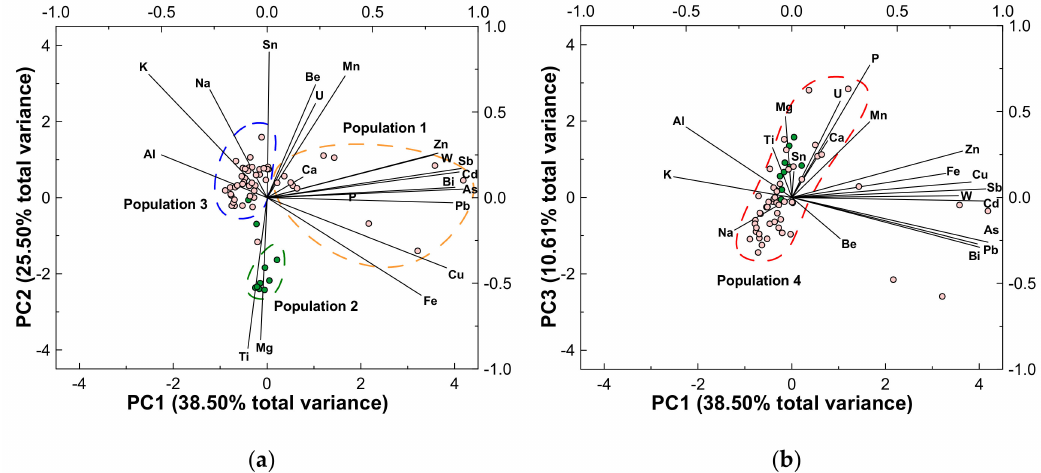
Figure 5. ( a ) Biplot of principal component 1 (PC1) versus principal component 2 (PC2) and ( b ) bivariate diagram with principal component 3 (PC3) as a function of PC1. Scores for samples are plotted against the bottom and left axes, while the eigenvectors for variables are plotted on the top and right axes. Pink and green circles correspond to samples collected on granitic and metasedimentary bedrock,